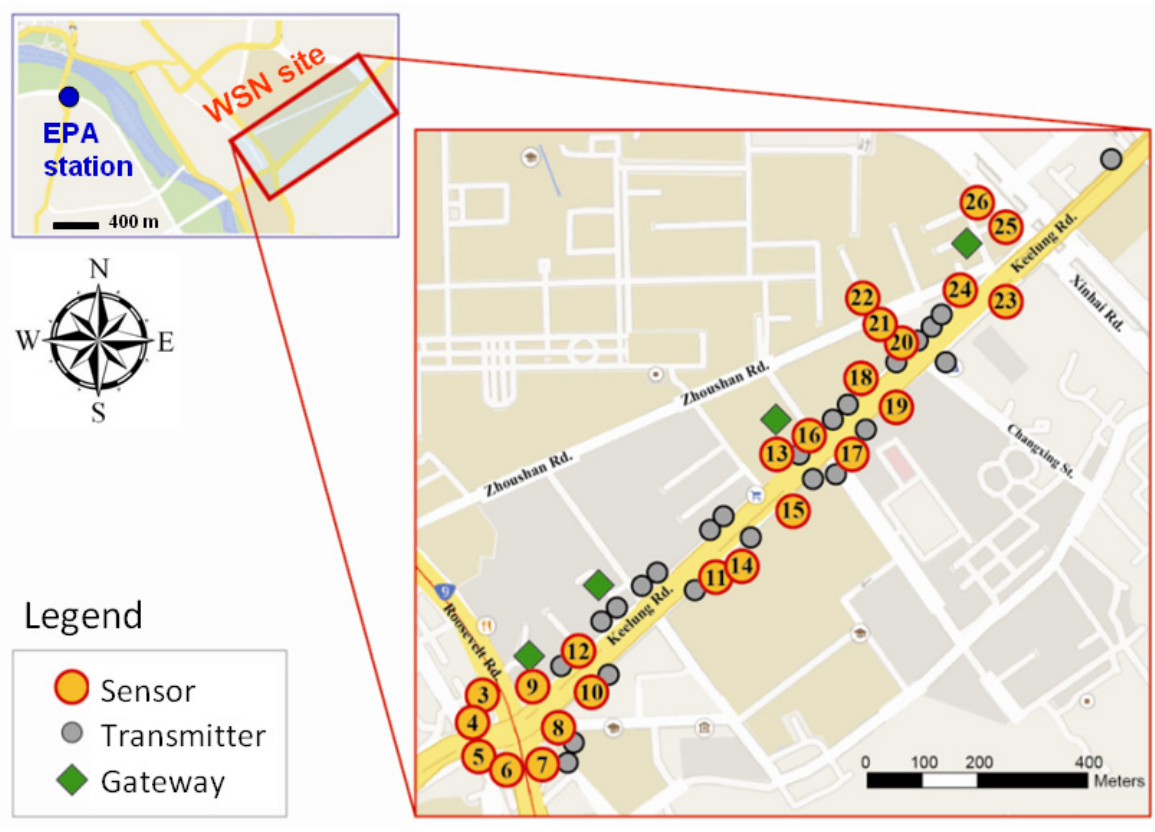
Figure 2. Study area: The wireless sensor network was distributed along an arterial connecting a residential area and the central business district and a circle intersecting another arterial connecting the south and north of the city. The yellow dots present the air pollutant sensors, the grey dots symbolize the transmitters and the green diamonds are the data gateway nodes of the wireless sensor